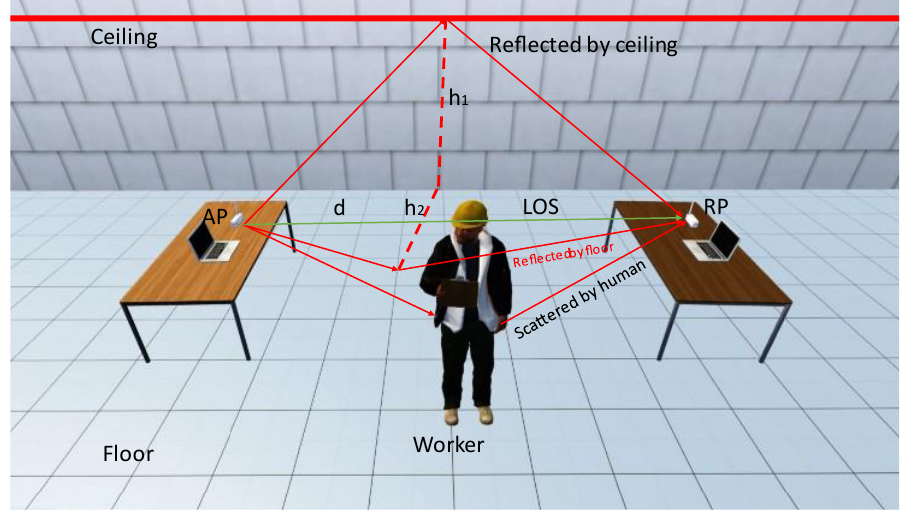
Figure 2. The wireless propagation model.